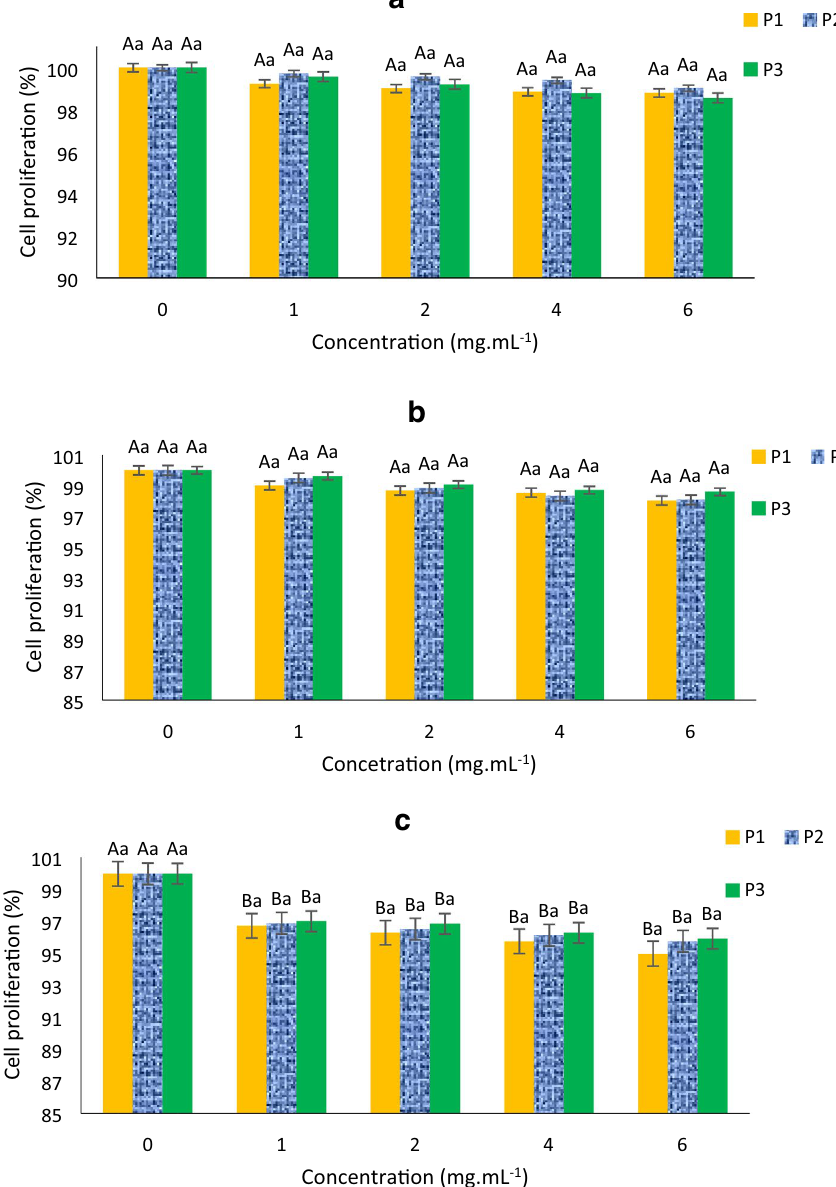
Figure 4. Cytotoxicity of the synthesized peptides at different concentrations. The cytotoxicity of the three peptides (P1, P2, and P3) were tested by the inhibition of the proliferation of ( a ) L929, ( b ) RAW264.7, and ( c ) Caco-2 cell lines. Different uppercase and lowercase letters represent the significant difference among various concentrations of the same peptide and various peptides at the same concentrations,